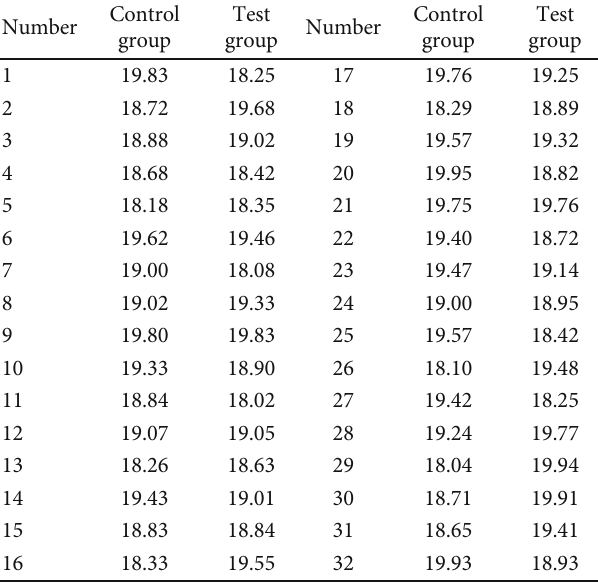
Table 1: Comparison of disease course before treatment.